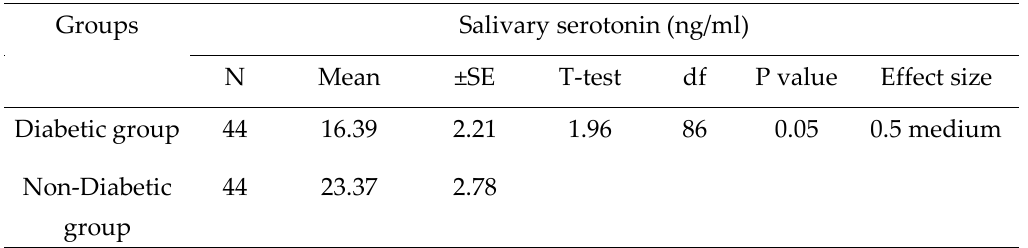
Table (4): The concentration of salivary serotonin in saliva (ng/ml) in both diabetic and non-diabetic groups